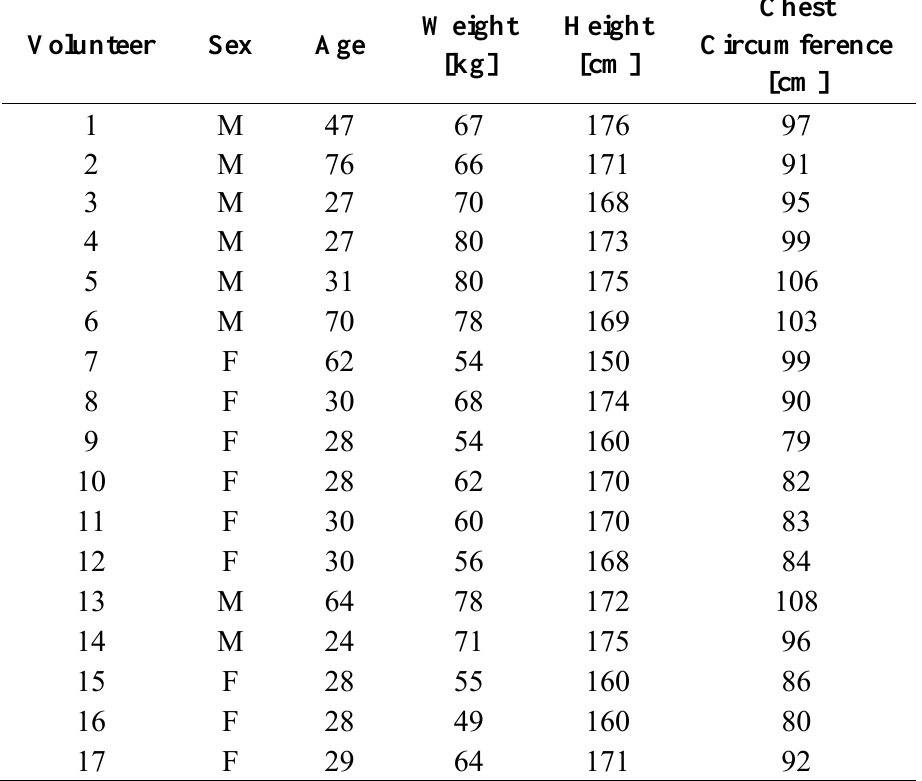
Table 1. Series of parameters associated to the experimental sample.